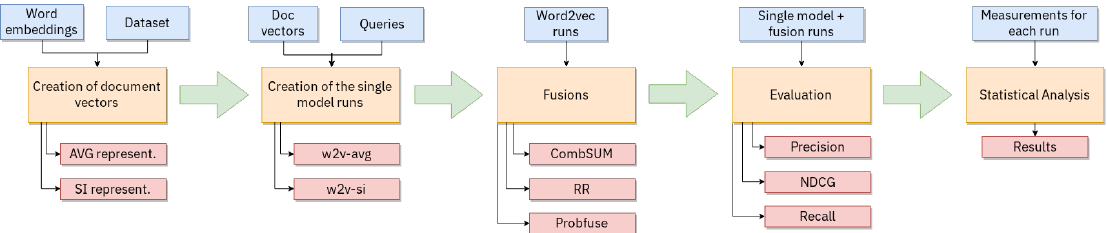
Figure 3. Graph showing the pipeline steps done in order to do the word2vec runs.